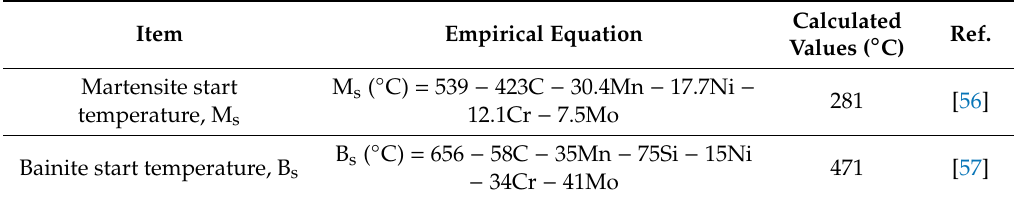
Table 1. The empirical equations applied for calculating martensite (M s ) and bainite (B s ) start